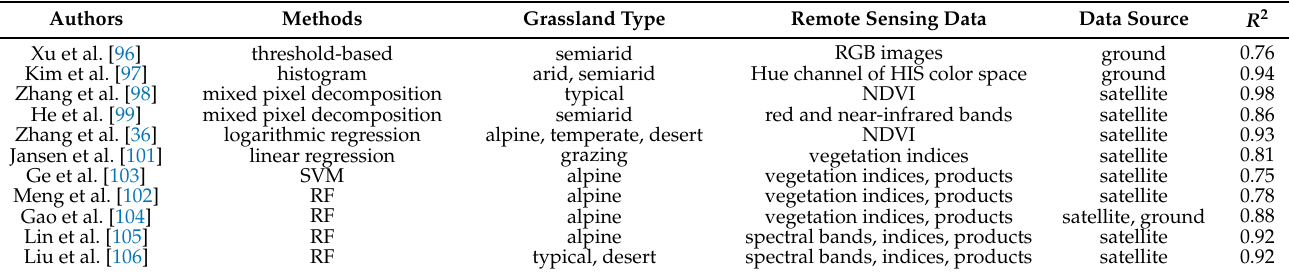
Table 4. Detailed information on the involved estimation studies for